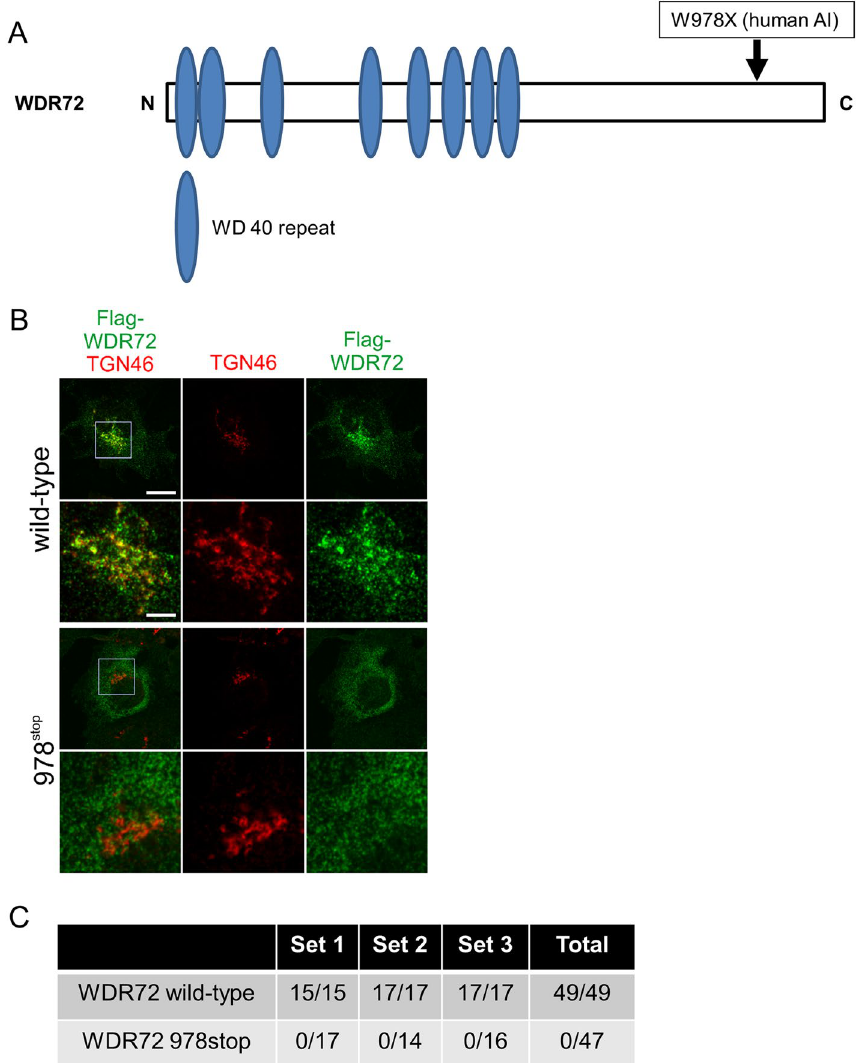
Figure 5. Wild-type WDR72, but not the Amelogenesis Imperfecta (AI) mutant WDR72 form, enriches in the Golgi area. ( A ) Schematic presentation of WDR72 protein with WD 40 repeat motif. The location of W978X mutation is indicated by an arrow for the reference. ( B ) Co-immunofluorescence analysis in COS-7 cells of Flag-WDR72 wild-type and the Amelogenesis Imperfecta (AI) mutant W978stop in comparison with the TGN46 was performed. The lower panels for each WDR72 (wild-type or 978 stop ) show a higher magnification of the area boxed in the merged panel, and of the respective corresponding area in TGN46 and Flag-WDR72 panels shown at a lower magnification. Scale bar represents 25 μm and 5 μm in the low and high magnification images, respectively. ( C ) Quantification of wild-type and AI mutant WDR72 forms localization to the Golgi. To quantitatively analyze the localization of wild-type and AI WDR72 forms, cells were randomly selected per each experiment and these co-localizations were evaluated. Immunofluorescence imaging of co-staining for the endogenously expressed trans-Golgi marker TGN46 was used to score recruitment of the WDR72 forms to the Golgi. The number of cells with a pool of WDR72 at the Golgi and the total number of cells analyzed for each condition are shown for three independent repeats of the experiment (Set 1, Set 2 and Set